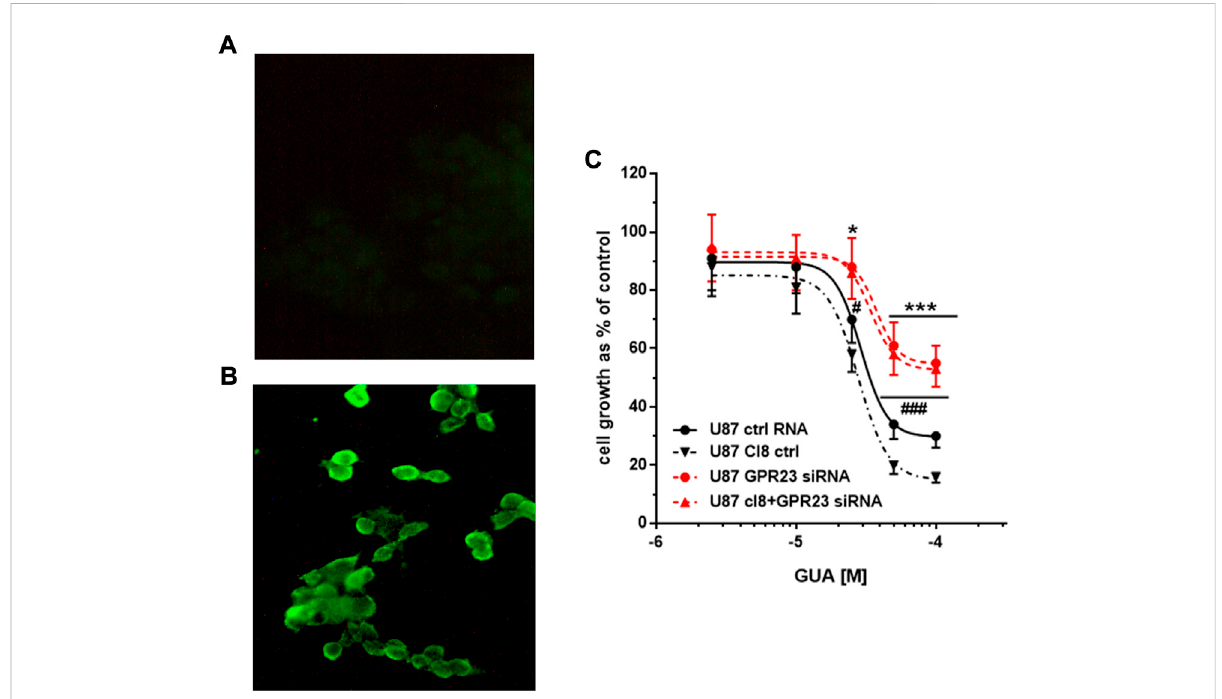
FIGURE 3 EffectofGPR23overexpressiononsensitivitytoGUA. (A,B) Immuno fl uorescencemicrophotographsofaGPR23-overexpressingU87cellclone (U87cl12). Expression of V5-tagged recombinant GPR23 was induced in U87cl12 cells by TAG on Demand adenoviral transduction and detected by the anti-V5-FITC conjugated antibody. (A) not-transduced U87cl12 cells stained with anti-V5-FITC antibody; (B) transduced U87cl12 cells stained with anti-V5- FITC antibody. The images are representative of six independent experiments performed with different clones overexpressing GPR23, which gave similar results. (C) Following stable overexpression of GPR23, some of these cells (U87cl8) were lipotransfected in the presence of 50 nM ctrlRNA (ctrl RNA) or GPR3-siRNA (GPR23siRNA). Twenty-four hours after this procedure, all cells were exposed to GUA (1 – 100 μ M) for 72 h. Results, expressed as the percentage of cell growth evaluated in untreated cells (control) by the MTT assay, are the mean ± SD of 4 different experiments for each cell type. * p < 0.05 ** p < 0.001 and # p < 0.05 ### p < 0.001: statistical signi fi cance vs. U87 ctrl RNA and U87 cl8, respectively (Student ’ s t test).